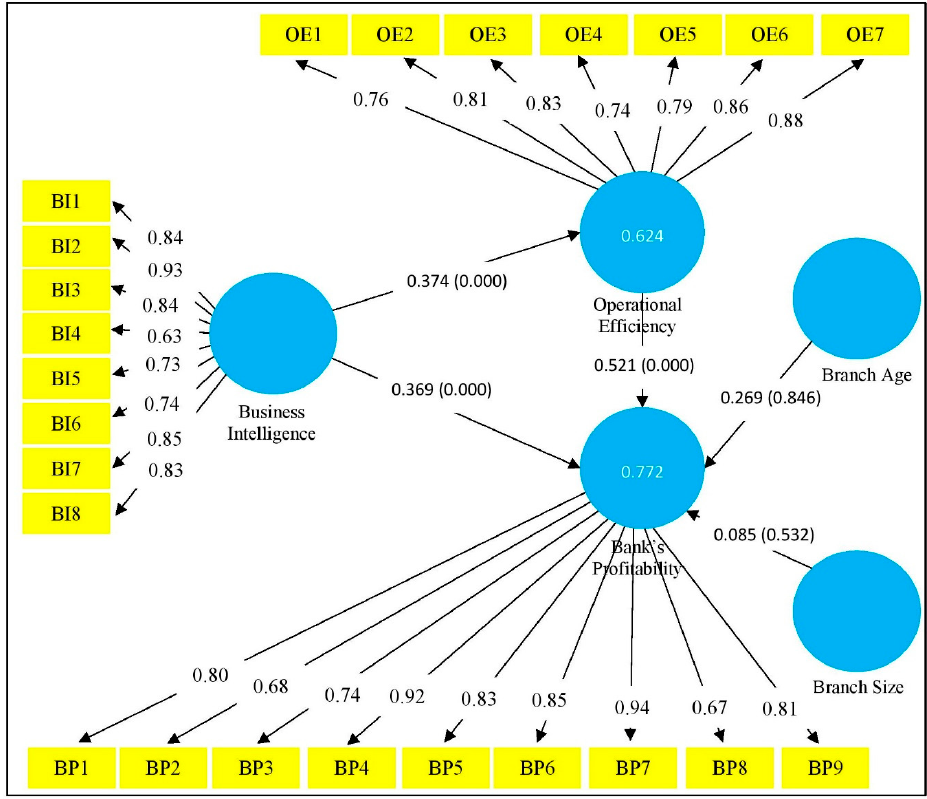
Figure 2. Author’s calculation.